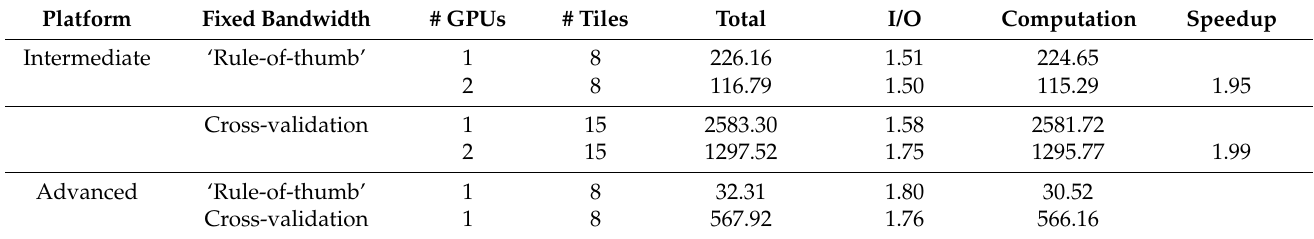
Table 8. Execution time (in minutes) for density estimation with fixed bandwidth on the eBird dataset ( n = 13,806,513 points; density raster cell size = 1 km; geographic extent: latitudes 60° S–75° N).